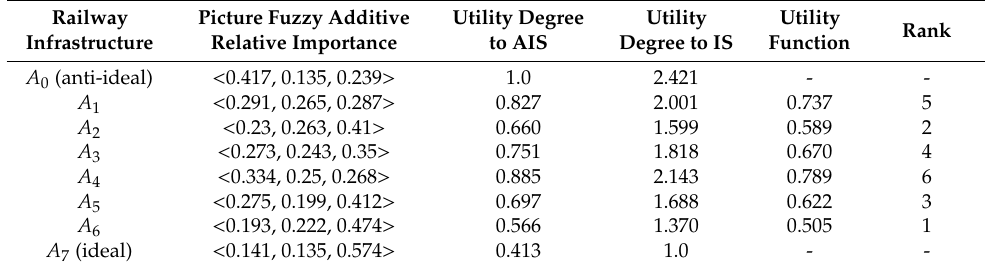
Table 11. The railway infrastructure additive relative importance, utility degrees, utility functions, and ranks. Railway Picture Fuzzy Additive Infrastructure Relative Importance